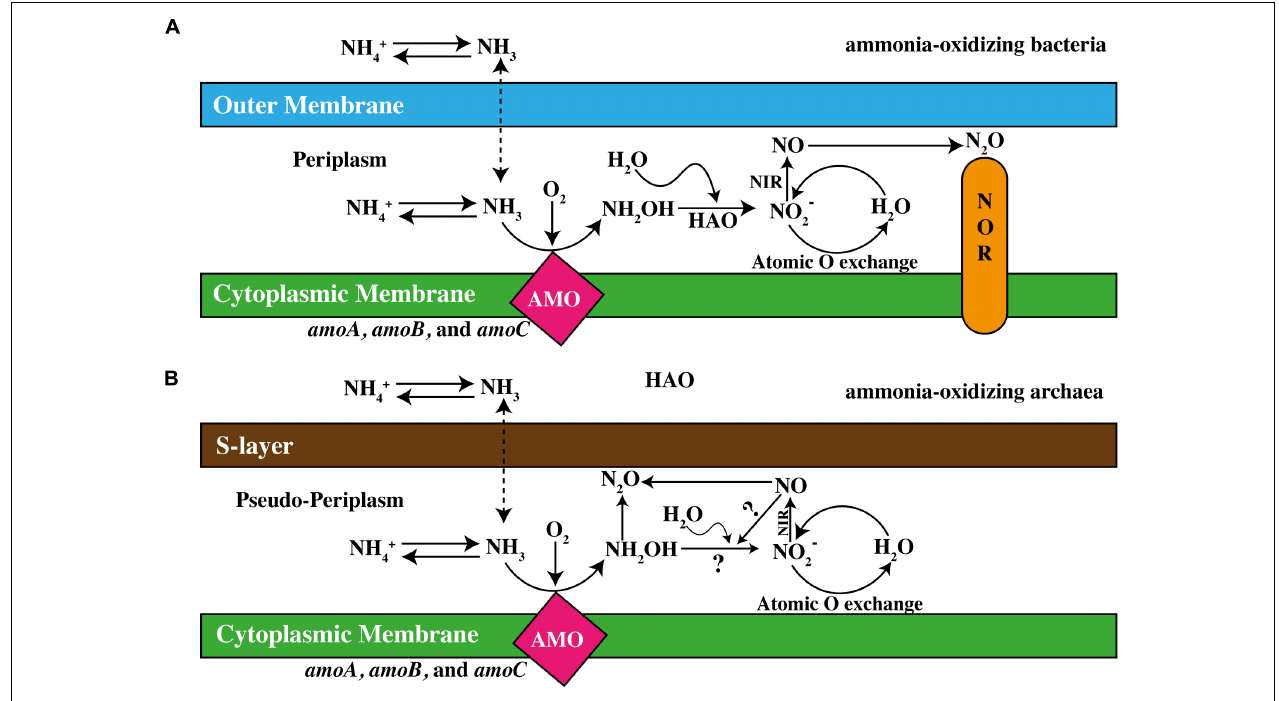
FIGURE 2 | Demonstration of ammonia-oxidation in (A) ammonia-oxidizing bacteria (AOB) and (B) ammonia-oxidizing archaea (AOA). HAO, hydroxylamine dehydrogenase; NIR, nitrite reductase; NOR, nitric oxide reductase (adapted from Yin et al.,